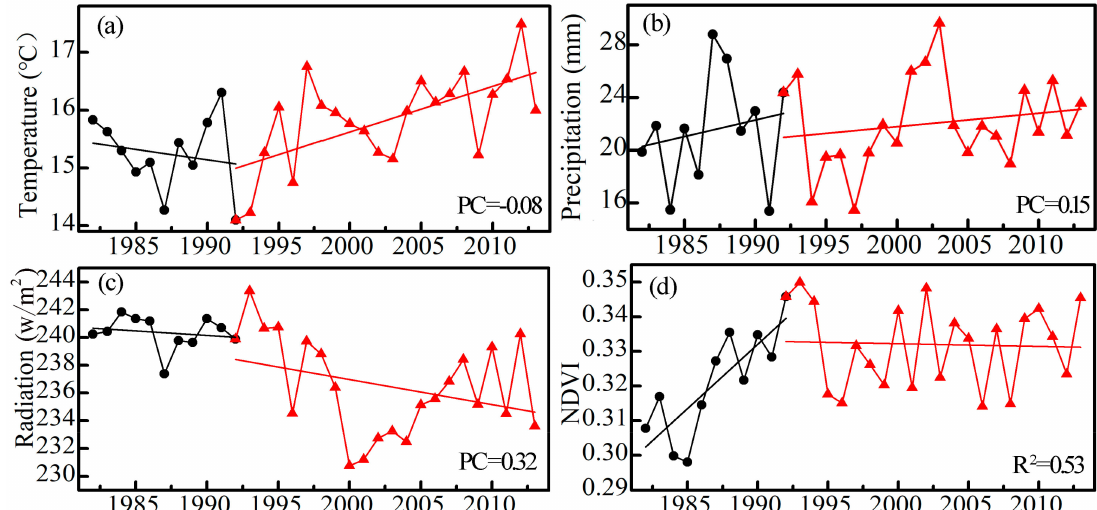
Figure 8. Climatic factors and NDVI variations in northern central Asia from 1982–2013. ( a ) Temperature (T); ( b ) precipitation (P); ( c ) radiation (R); and ( d ) NDVI; the black line and the red line represent the changing trends before and after the temperature change. PC represents the partial correlation coefficient of each climatic factor with NDVI, excluding the other two meteorological variables, and R 2 represents the coefficient of determination between the NDVI and the meteorological factors. The relationship between NDVI and the